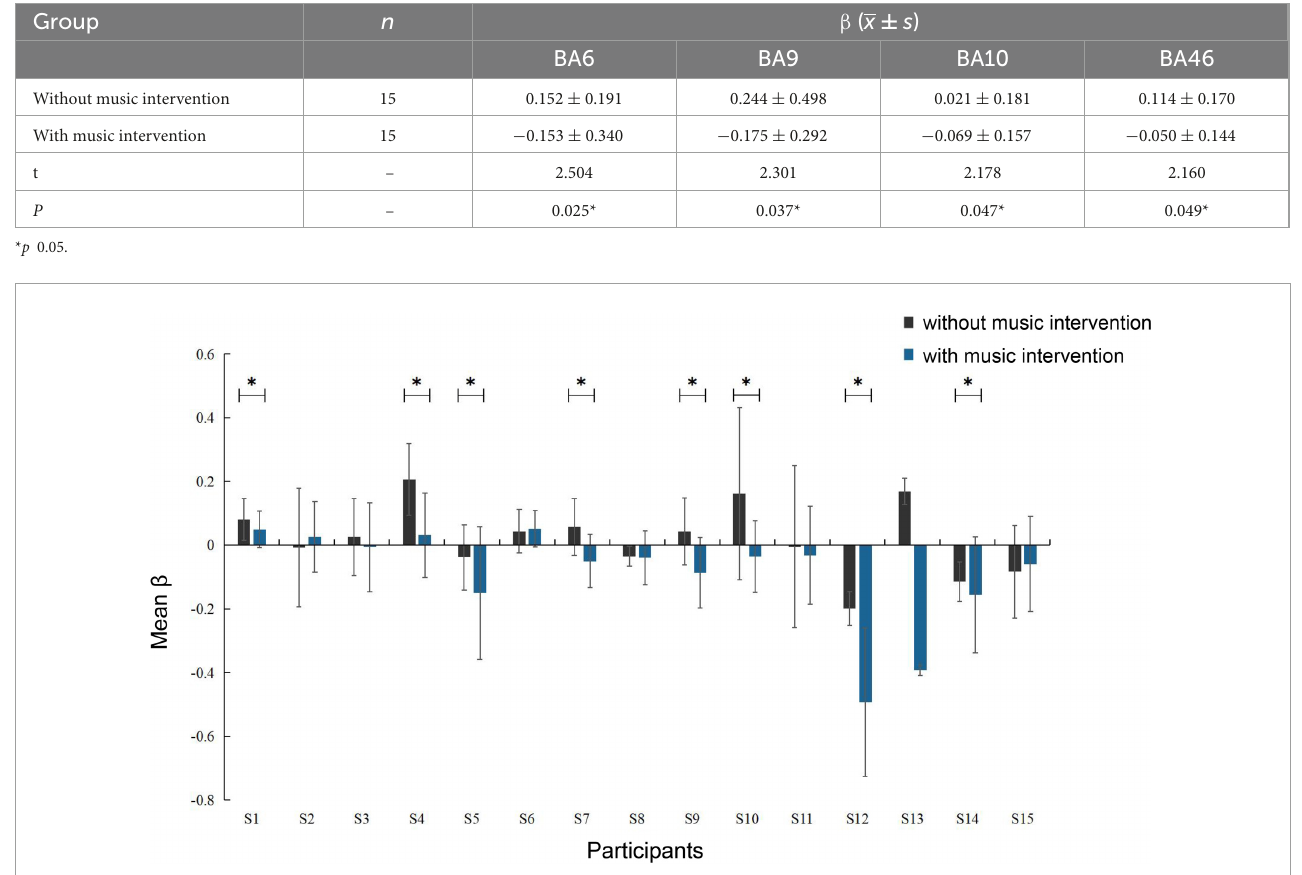
FIGURE5 Degree of activation of brain areas in conditions with and without music intervention ( ∗ p < 0.05). The error bars indicate the standard error of the mean.